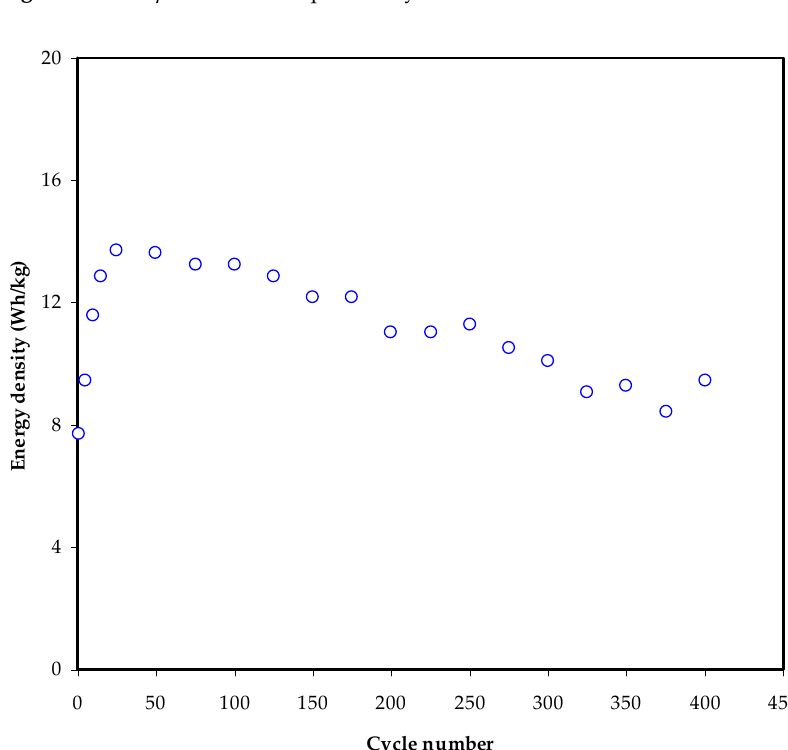
Figure 11. The η of the EDLC up to 400 cycles.